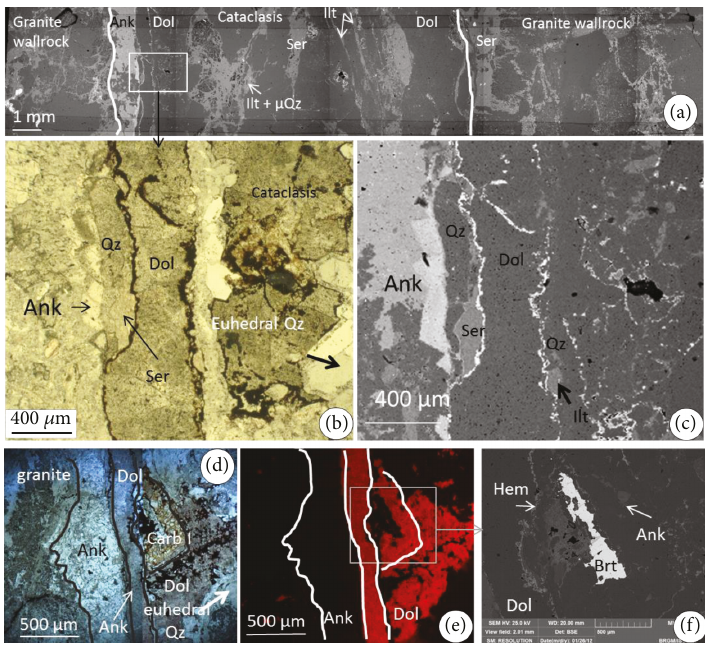
Figure 11: Polyphase fi lling in a microfracture that crosscuts the Waldhambach granite (images modi fi ed from [119]). (a) BSE image of the entire fi lling; (b) detail of textural relationships between cataclasis, euhedral quartz, and carbonates (dolomite and ankerite) (natural light); (c) the same zone in BSE; (d) detail showing the textural relationship between euhedral quartz, carbonates, and barite; (e) same image in CL: a fi rst type of carbonates is red orange color under CL, and the second type is not luminescent (Ankerite); (f) same image in